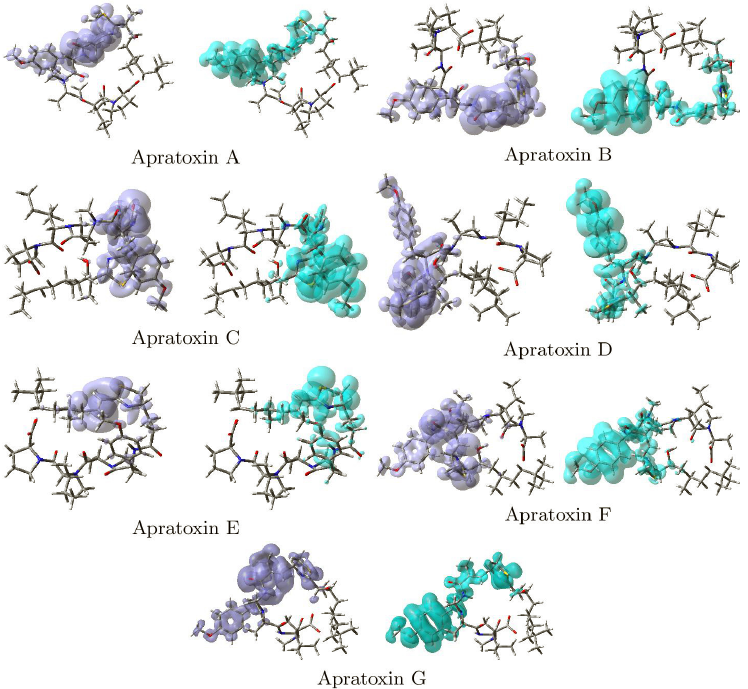
Figure 3. Graphical representation of the Dual Descriptor DD of the Apratoxin A, Apratoxin B, Apratoxin C, Apratoxin D, Apratoxin E, Apratoxin F and Apratoxin G molecules. Left: DD > 0, Right: DD <